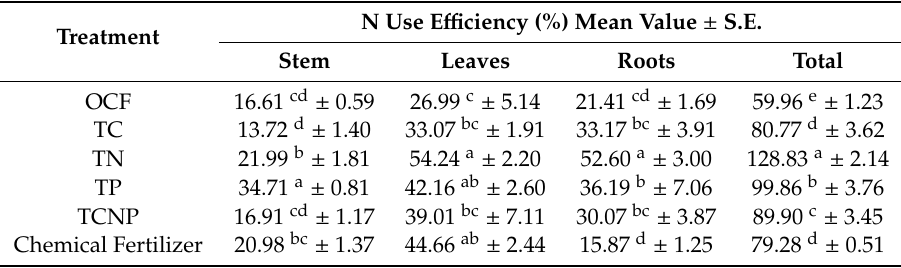
Table 5. E ff ect of treatments on nitrogen use e ffi ciency in maize plant parts. Table 5. Effect of treatments on nitrogen use efficiency in maize plant parts.